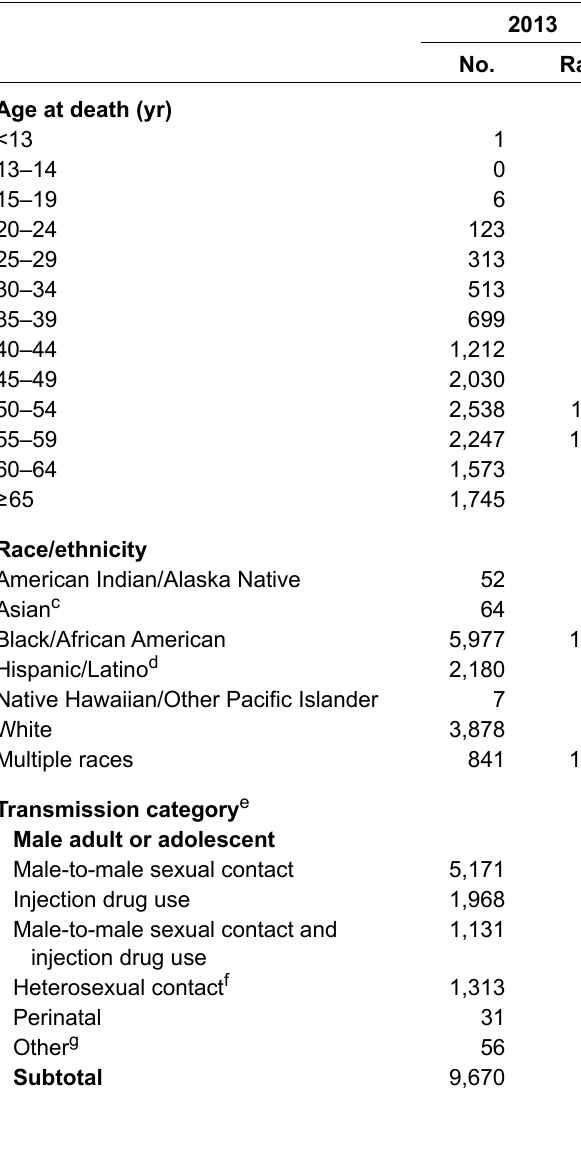
Table 19a. Deaths of persons with diagnosed HIV infection ever classified as stage 3 (AIDS), by year of death and selected characteristics, 2013–2017 and cumulative—United